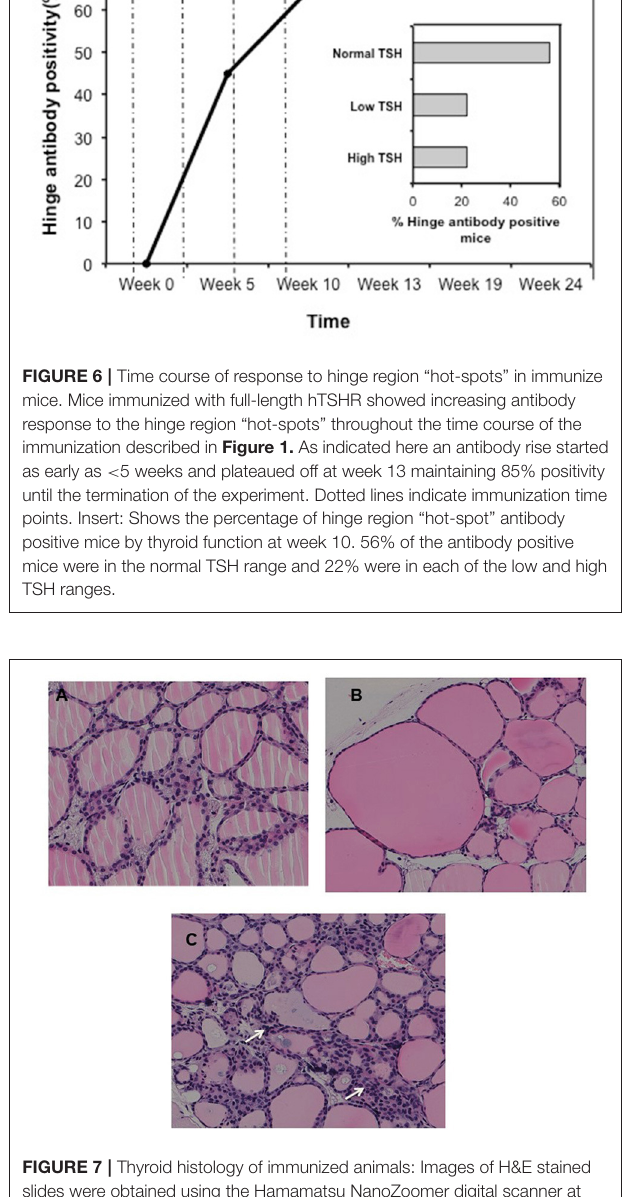
examination of thyroids from animals with antibodies directed to the hinge hotspots, in addition to other TSHR-Abs, showed variable pathological changes. These changes included